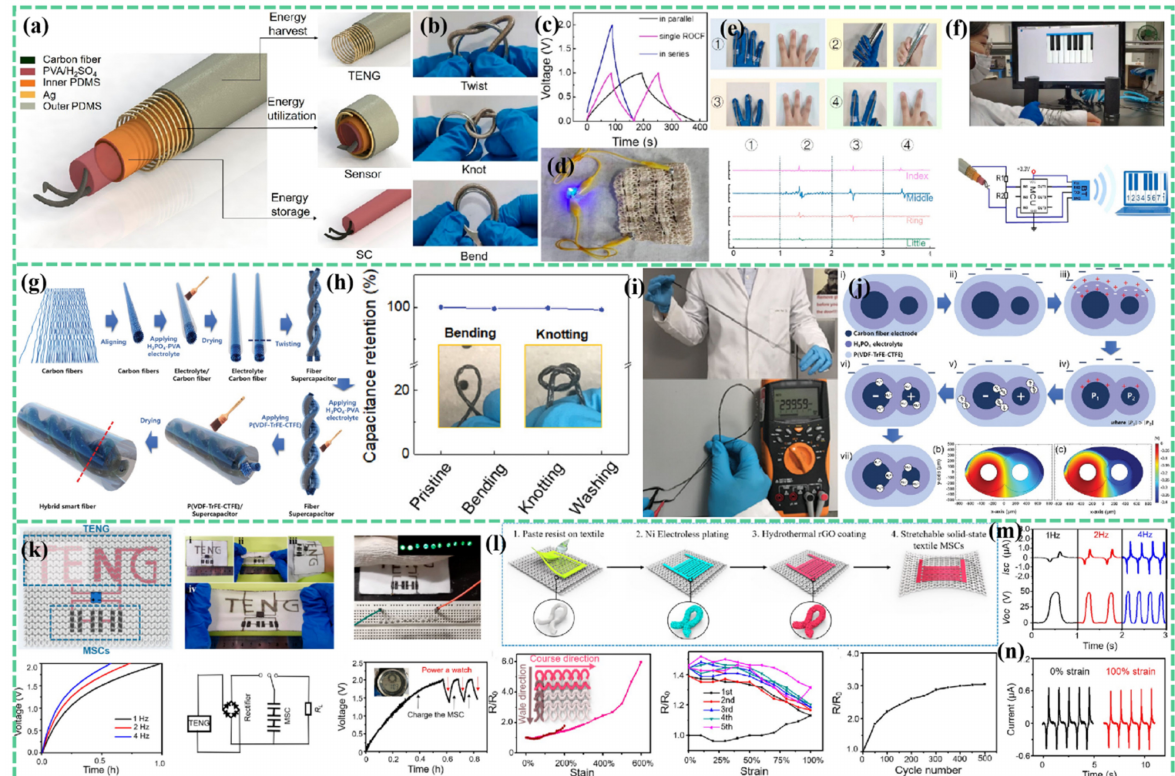
Figure 4. All-in-one uninterrupted power supply fibers and uninterrupted power supply textiles developed from fabric substrate ( a – f ) Multifunctional coaxial energy-autonomy fiber composed of an all fiber-shaped TENG, SC, and pressure sensor. ( a ) Structure diagram of TENG, sensor, and SC. ( b ) Photographs of different mechanical deformations. ( c ) GCD curves for two SCs in parallel and in series. ( d ) Photo of a blue LED powered by energy storage fabric. ( e ) Real-time voltage sensing signals under different gestures. ( f ) Photograph and circuit diagram of the energy fiber as the tactile interface of the electronic piano. Reproduced with permission [77]. Copyright 2021, American Chemical